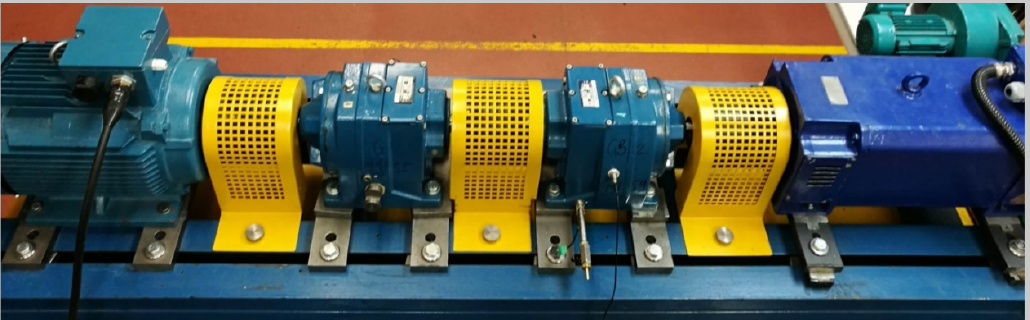
Figure 15. Helical gearbox test rig diagram.